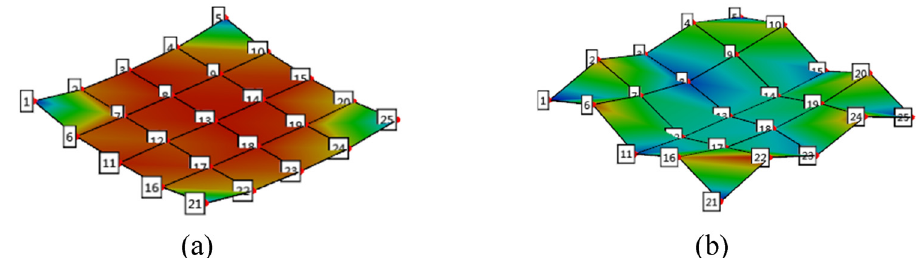
Figure 8: Structural mode test results: ( a ) 4.4 Hz; ( b ) 48.7 Hz.